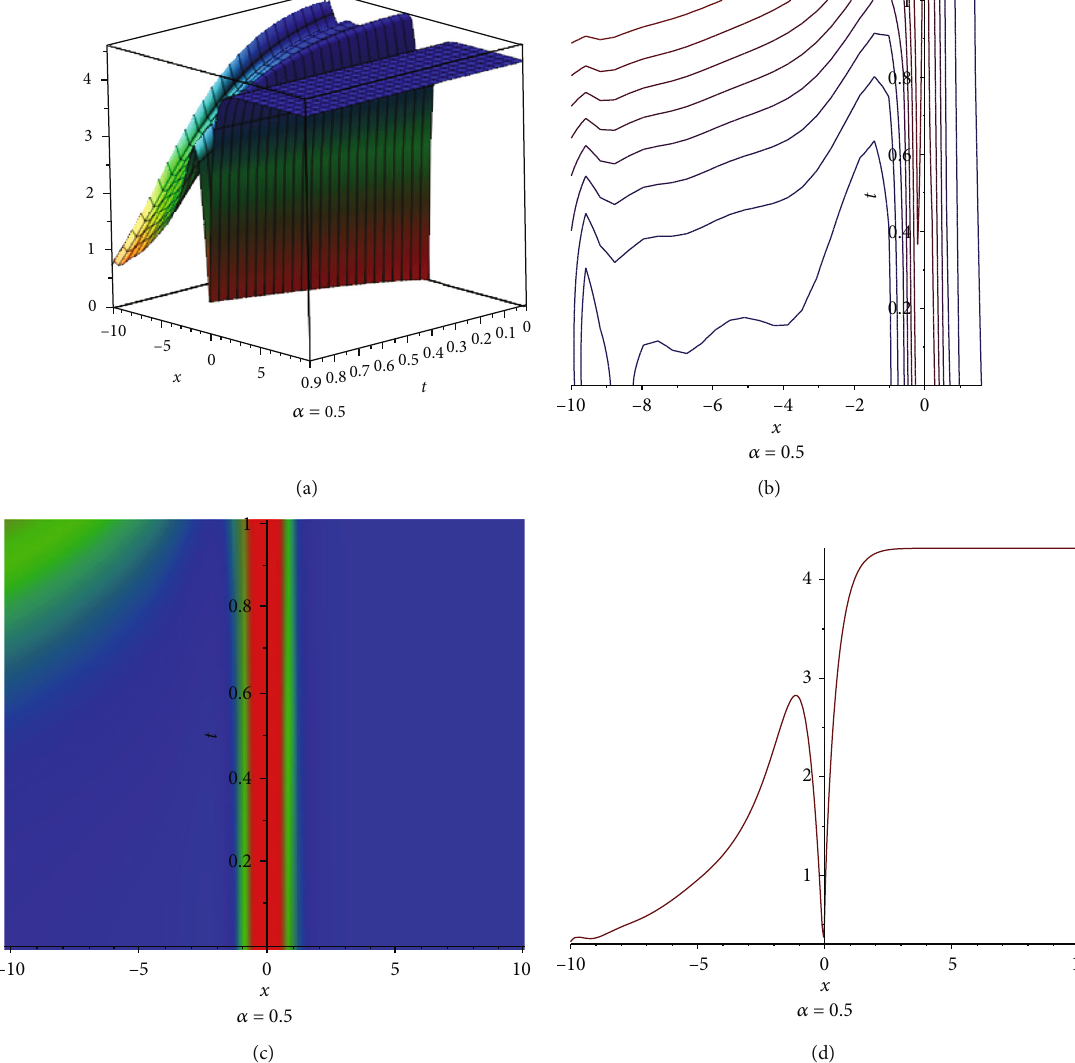
Figure 1: The graphical representations of j U 1